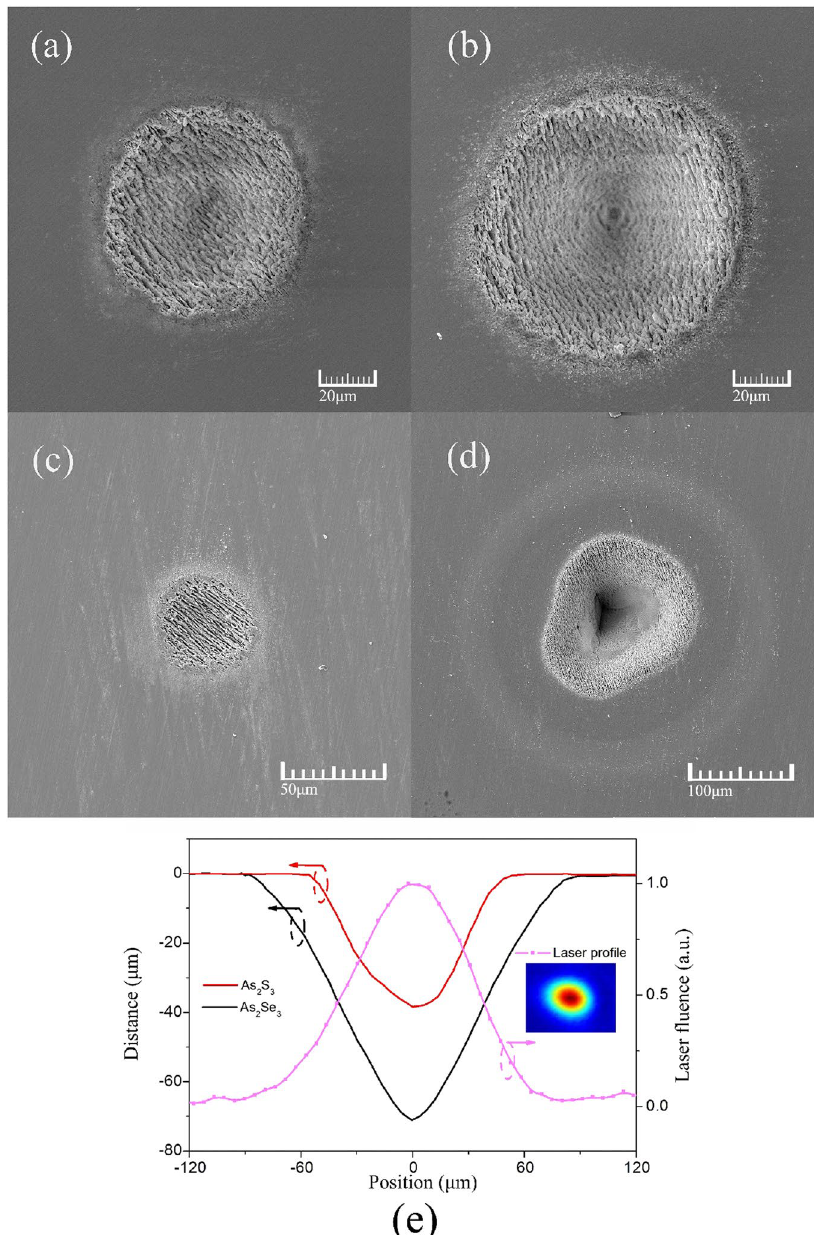
Figure 4. SEM micrographs of multi pulses damage spots at 3 μ m. The damage spots at P = P cr = 10 mW ( a ) and P = 30 mW ( b ) for As 2 S 3 , and at P = P cr = 5 mW ( c ) and at P = 30 mW ( d ) for As 2 Se 3 . ( e ) The beam intensity profile and the depth profiles of the damage craters at average laser power of 30